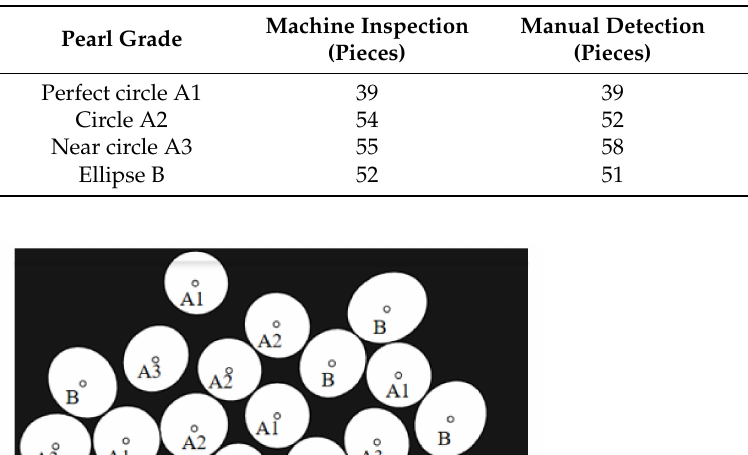
Table 7. Pearl grade classification results.